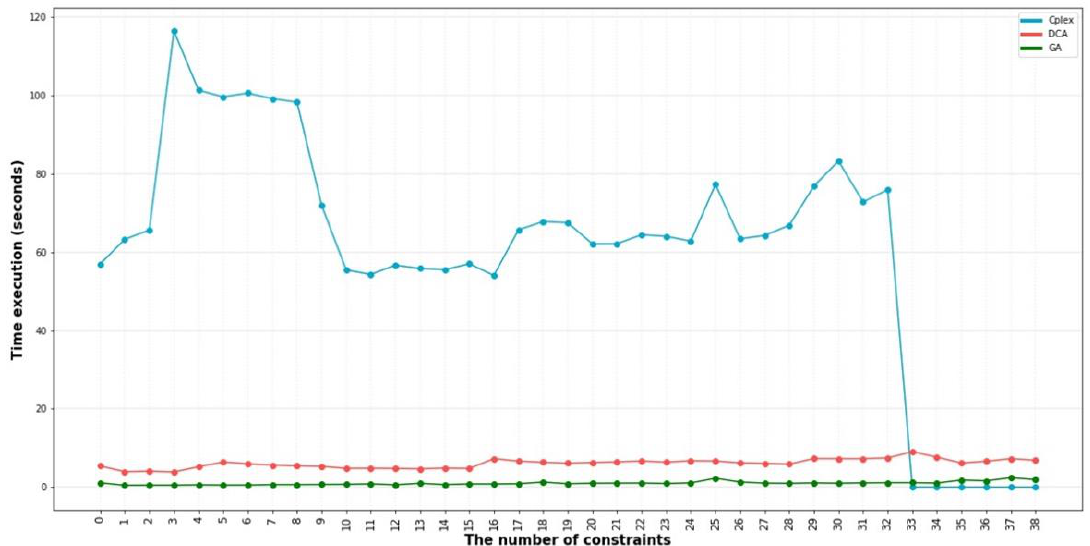
Figure 15. The time execution of the algorithms to find a team of three members from the top 2000 candidates.